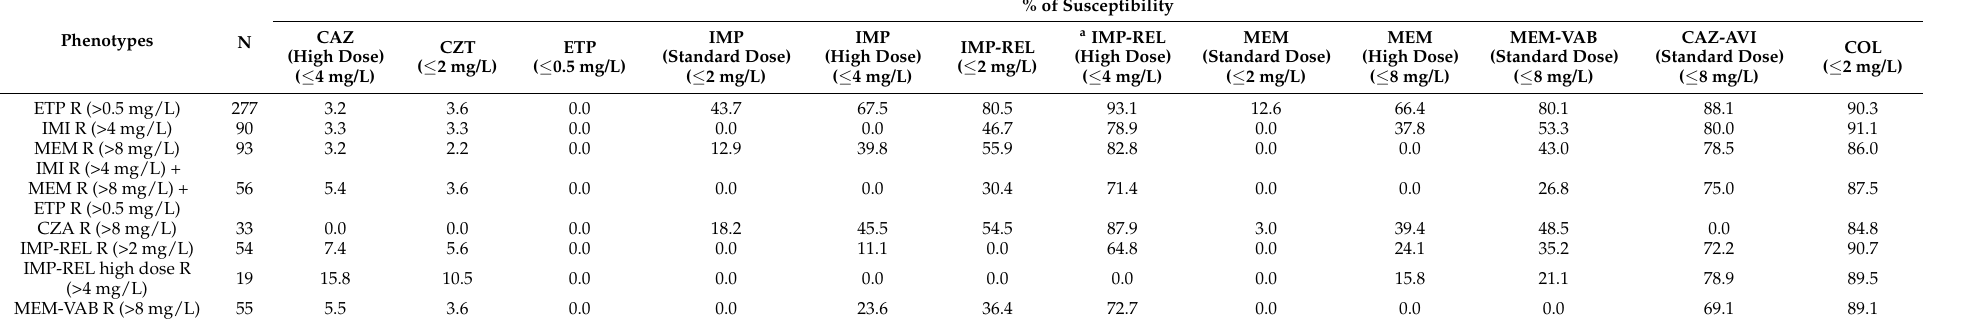
Table 3. Susceptibility rates to β -lactam, β -lactamase/inhibitors according to the dose of β